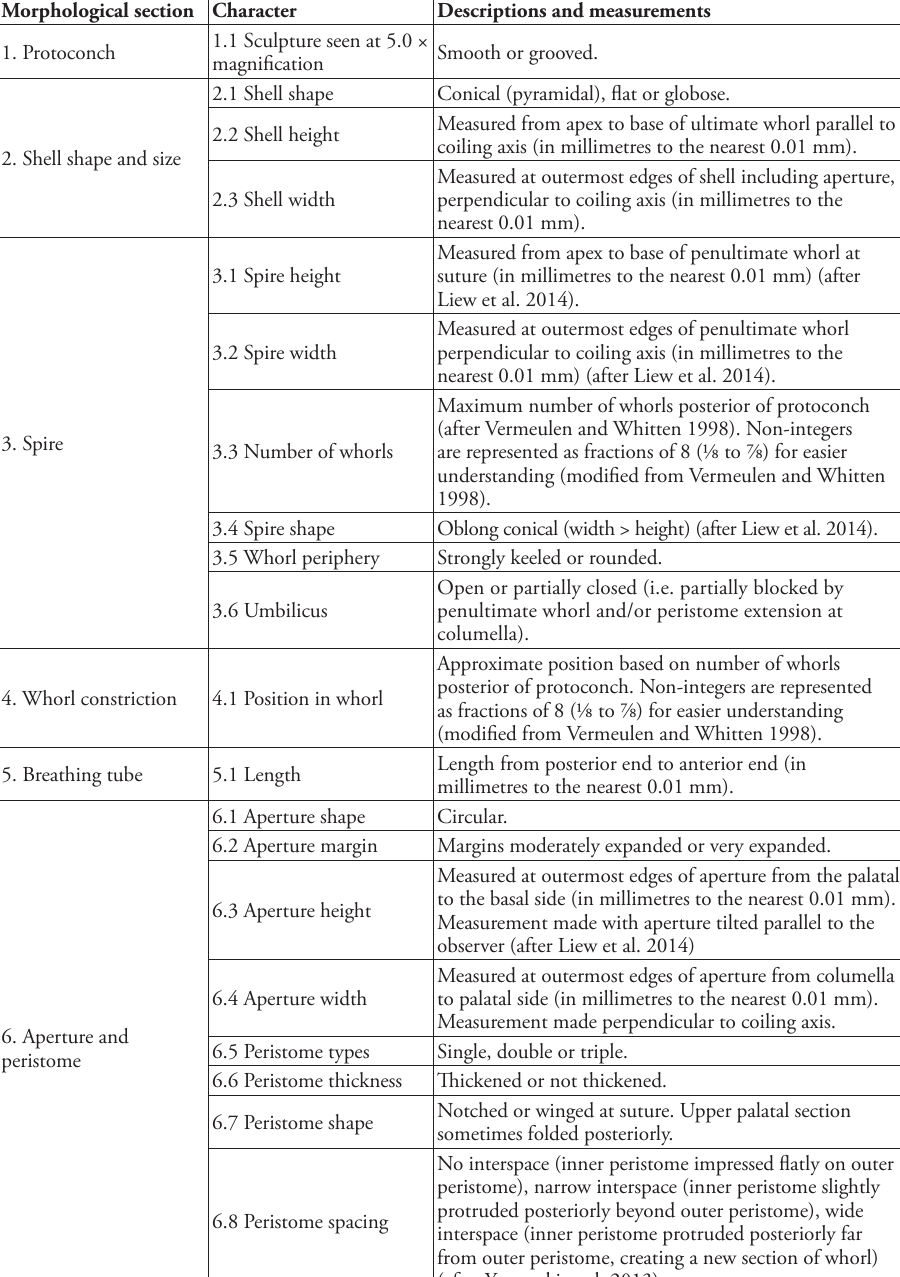
Table 1. Framework for species description based on 39 shell and operculum features, as well as living animal colour. Number codes are ascribed to each character and linked to illustrations in Figure 1 for visualisation of character descriptions and measurements, except shell colour and living animal